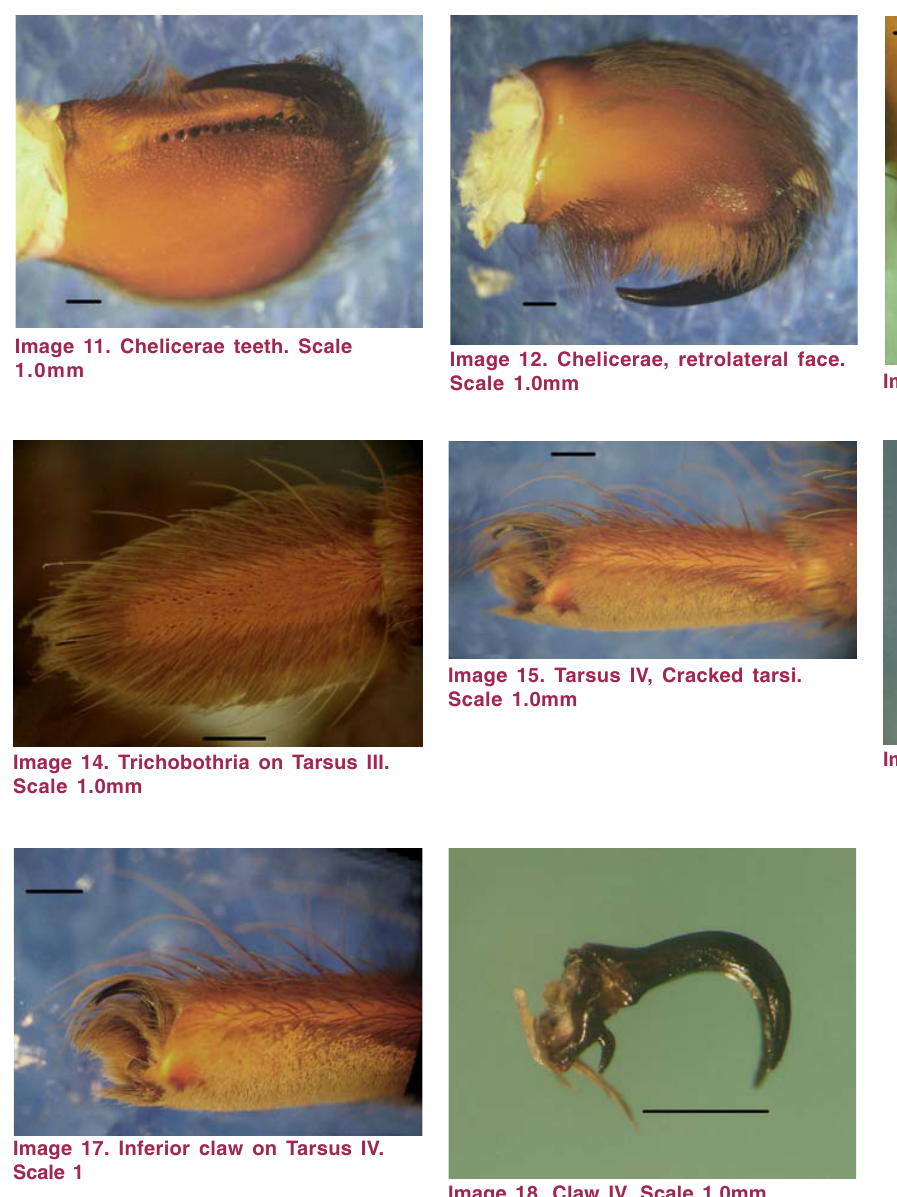
Image 18. Claw IV. Scale 1.0mm